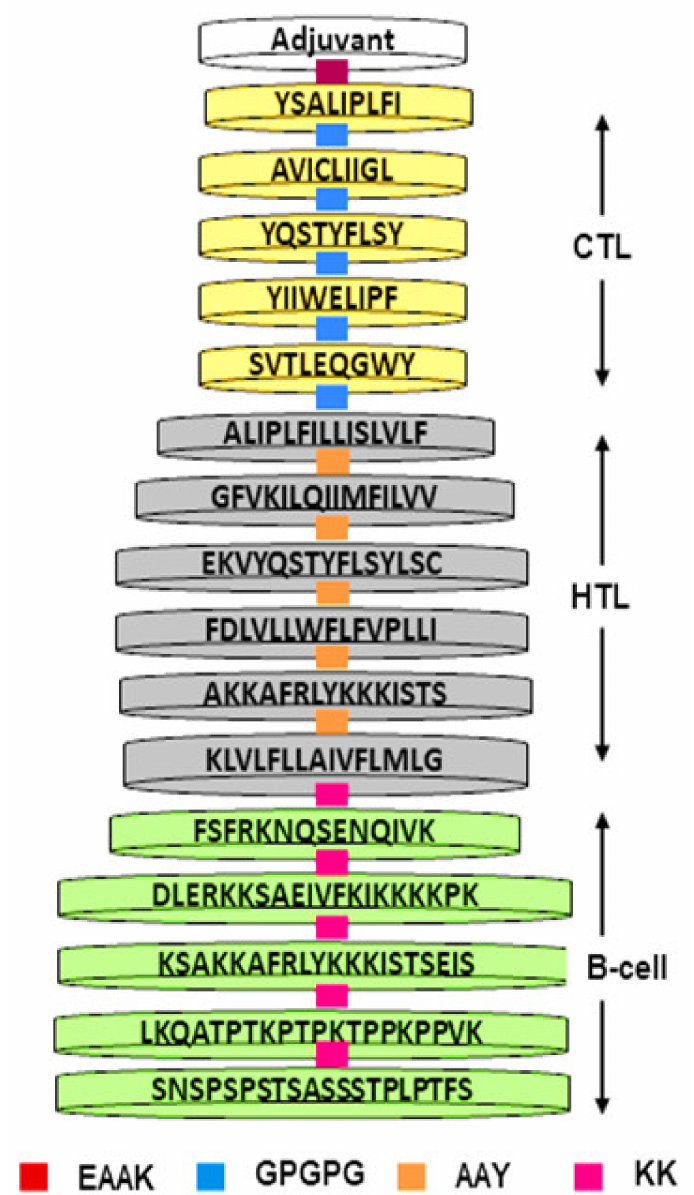
Figure 2. Scheme of the designed chimeric consisting of fused T cells joined via GPGPG and AAY and B cell epitopes connected via KK